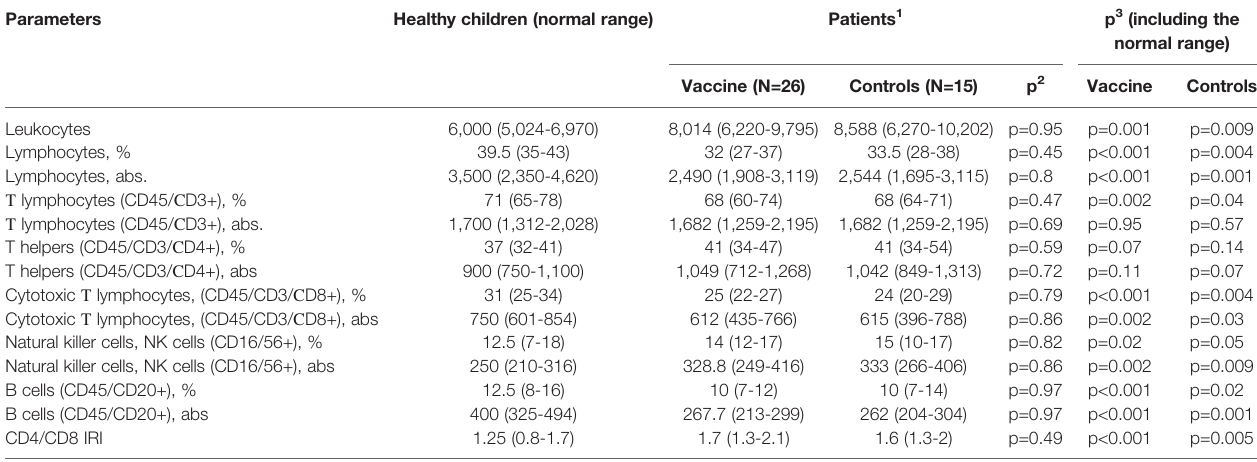
TABLE 2 | Comparative characteristics of peripheral blood lymphocyte subpopulations in children with a history of solid tumors and healthy ones aged 7-15 years. Parameters